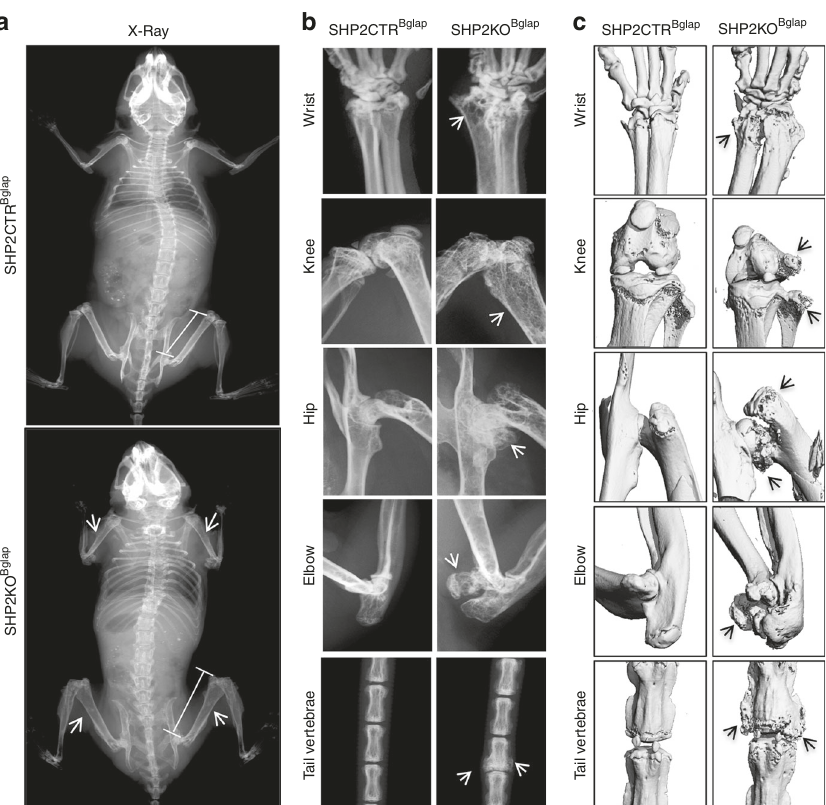
Fig. 1 Mice lacking SHP2 in Bglap + osteoblasts and osteocytes display skeletal dysplasia, reduced BMD, and the growth of enchondromas and osteochondromas. a Radiographs of 13-week-old SHP2CTR Bglap and SHP2KO Bglap mice showing the skeletal structure, femur length (lines), and BMD (arrows). X-ray ( b ) and µCT ( c ) radiographs of skeletal preps from the mice described in a . Note the reduced BMD, deformed knee and hip joints, and growth of osteochondromas in SHP2KO Bglap mice (arrows) ( n =